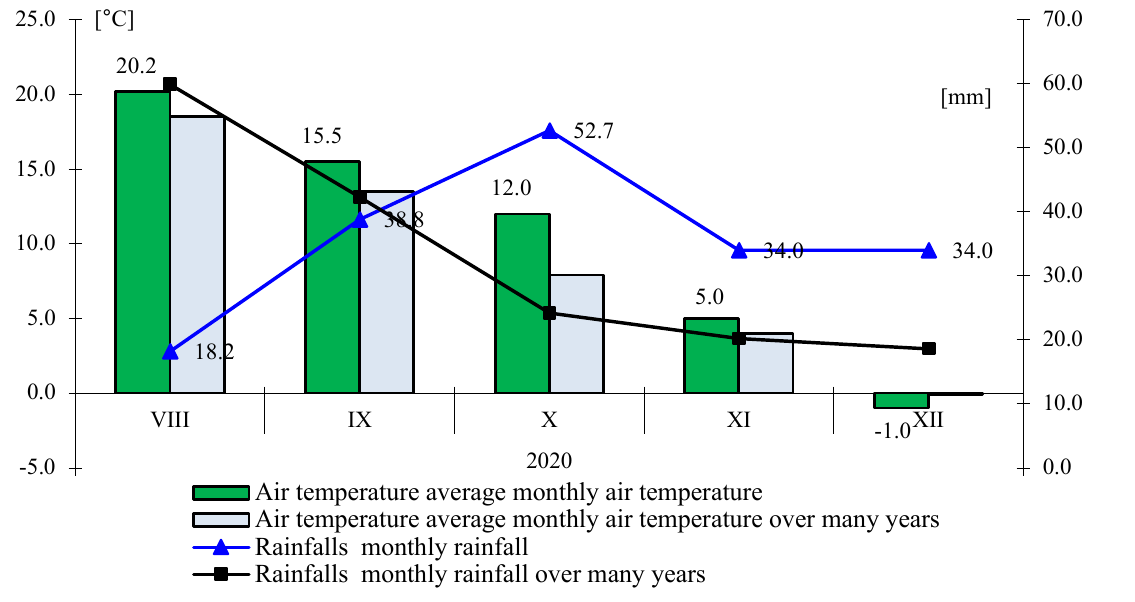
Figure 3. Monthly rainfall totals and average air temperature during the growing season